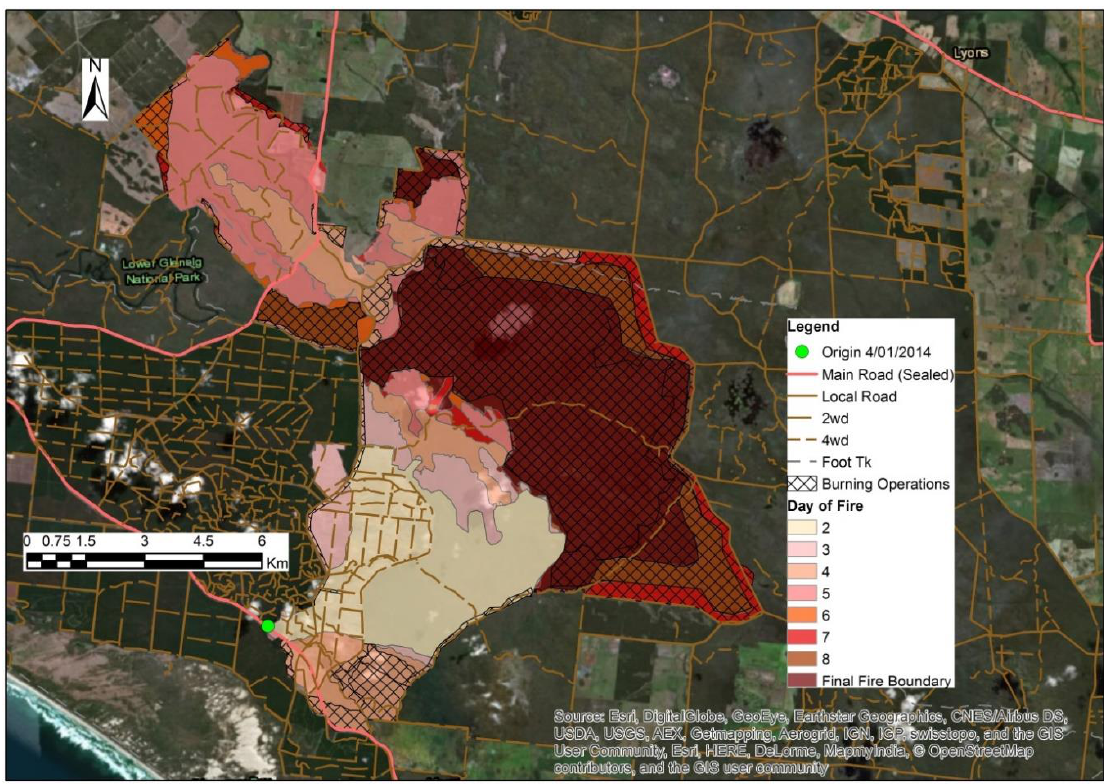
Figure A8. Kentbruck fire progression map.